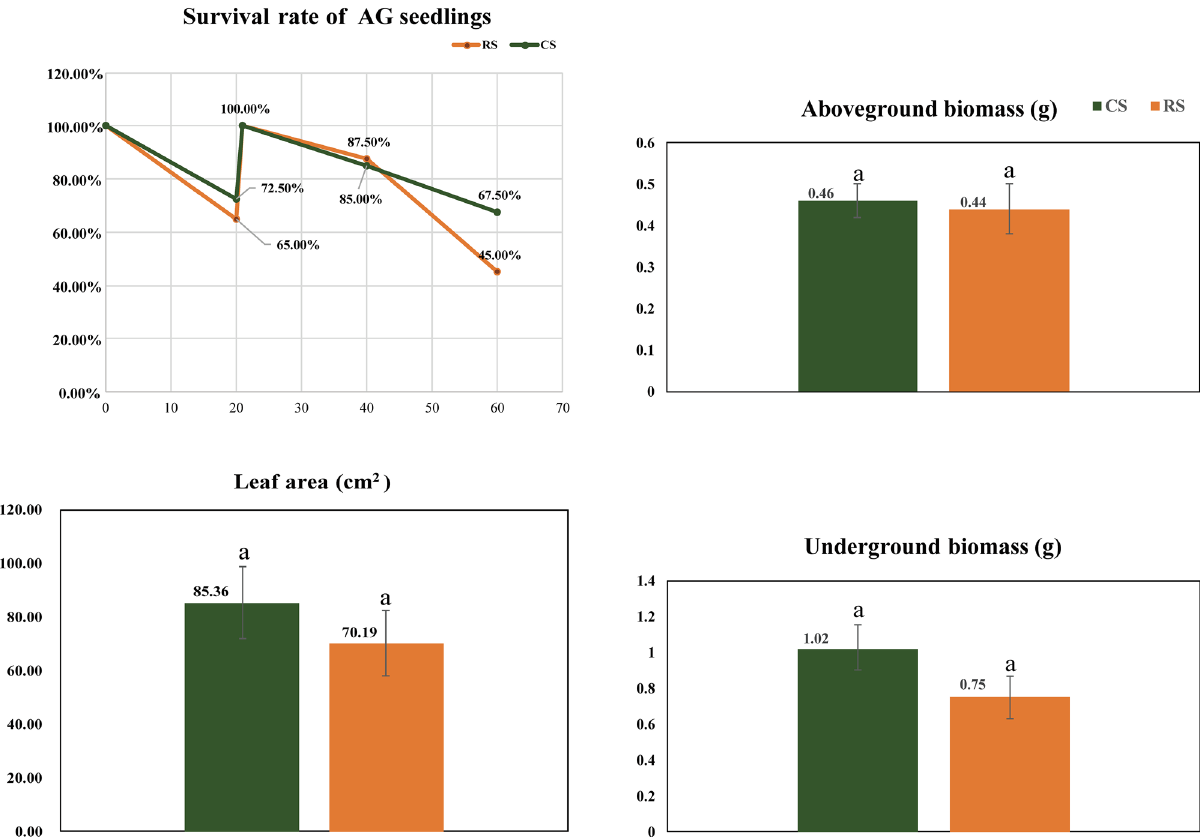
Figure 1. Survival rate and growth index of Panax quinquefolium in the pot experiment. The survival rate was calculated every 20 days. The aboveground and underground biomasses were calculated at the end of 60 days. Leaf area was calculated at the final harvest. CS: Plants in the CS group; RS: Plants in the RS group; a: means the difference is not significant ( P > 0.05). RS: the 10-year post-ginseng rotation soil; CS: soil in which no ginseng was grown before ginseng planting.